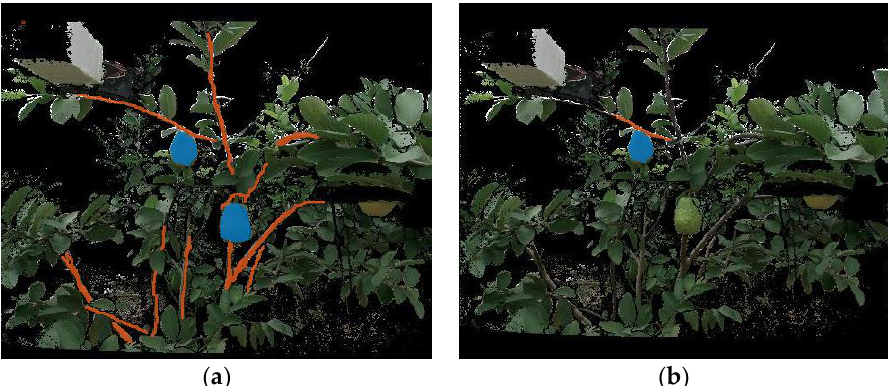
Figure 8. Example showing ground-truth labels. ( a ) Ground-truth labels for three classes: fruit (blue), branch (red), and background. ( b ) Ground-truth fruit (blue) and the corresponding mother branch (red).